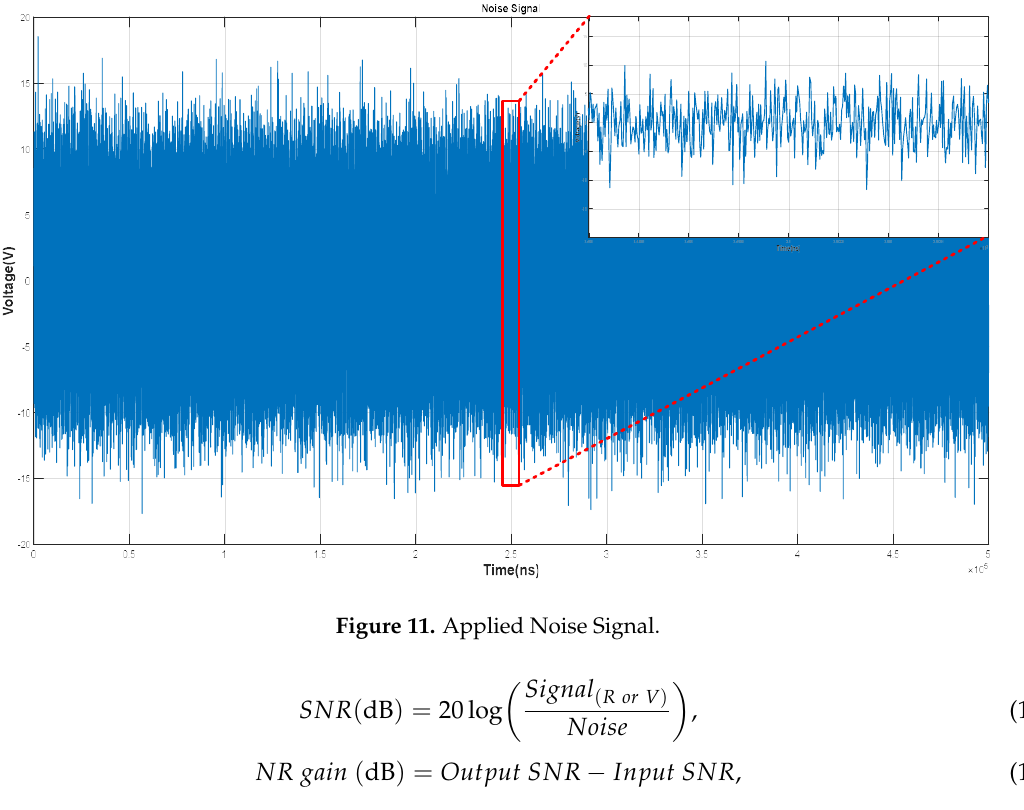
Table 4. SNR for Different Cases of Finger Features.